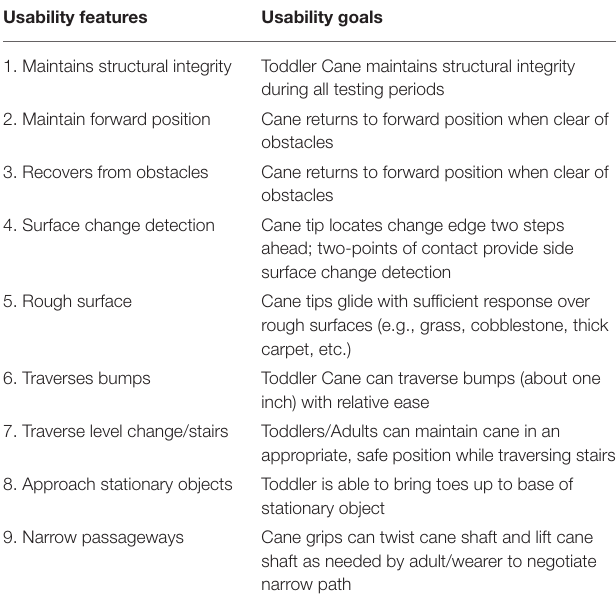
TABLE 1 | Toddler cane usability features and